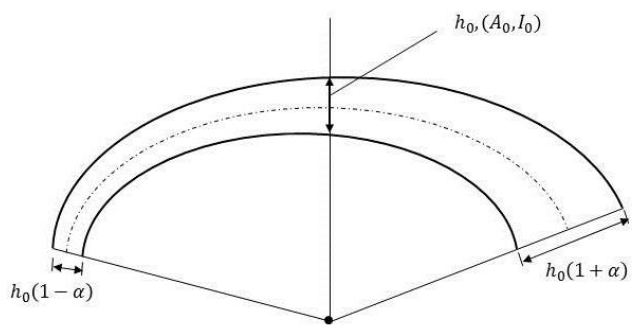
Figure 2. Linearly varying cross-sectional width of the curved beam.